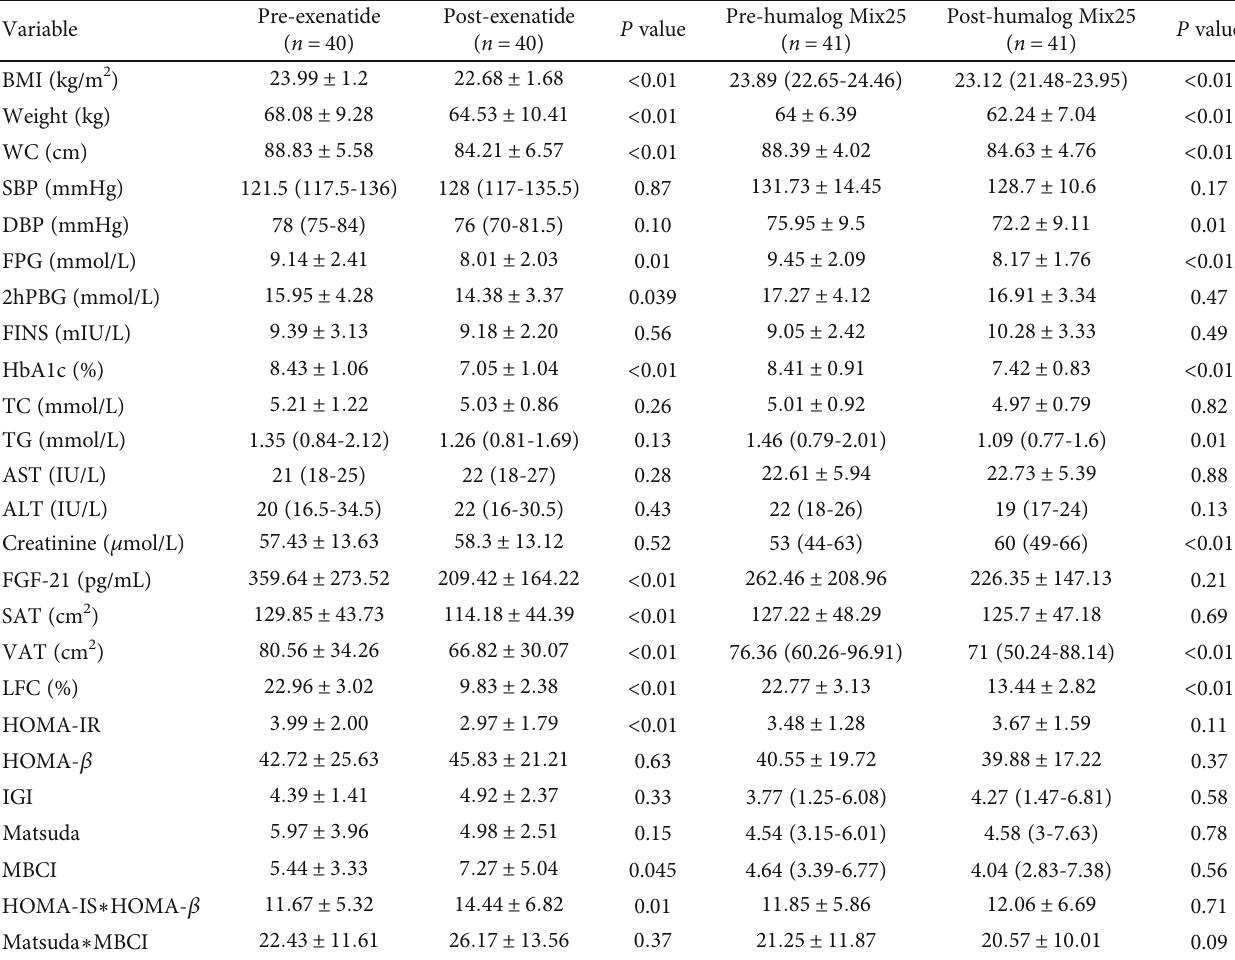
Table 2: Clinical, biochemical, and imaging parameters of normal BMI patients with T2DM and visceral adiposity before and after exenatide or humalog Mix25